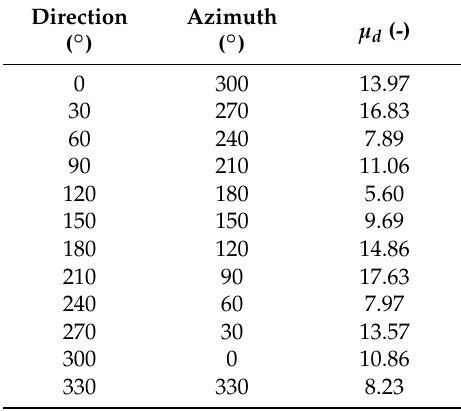
Table 4. Assessment of the ductility capacity.